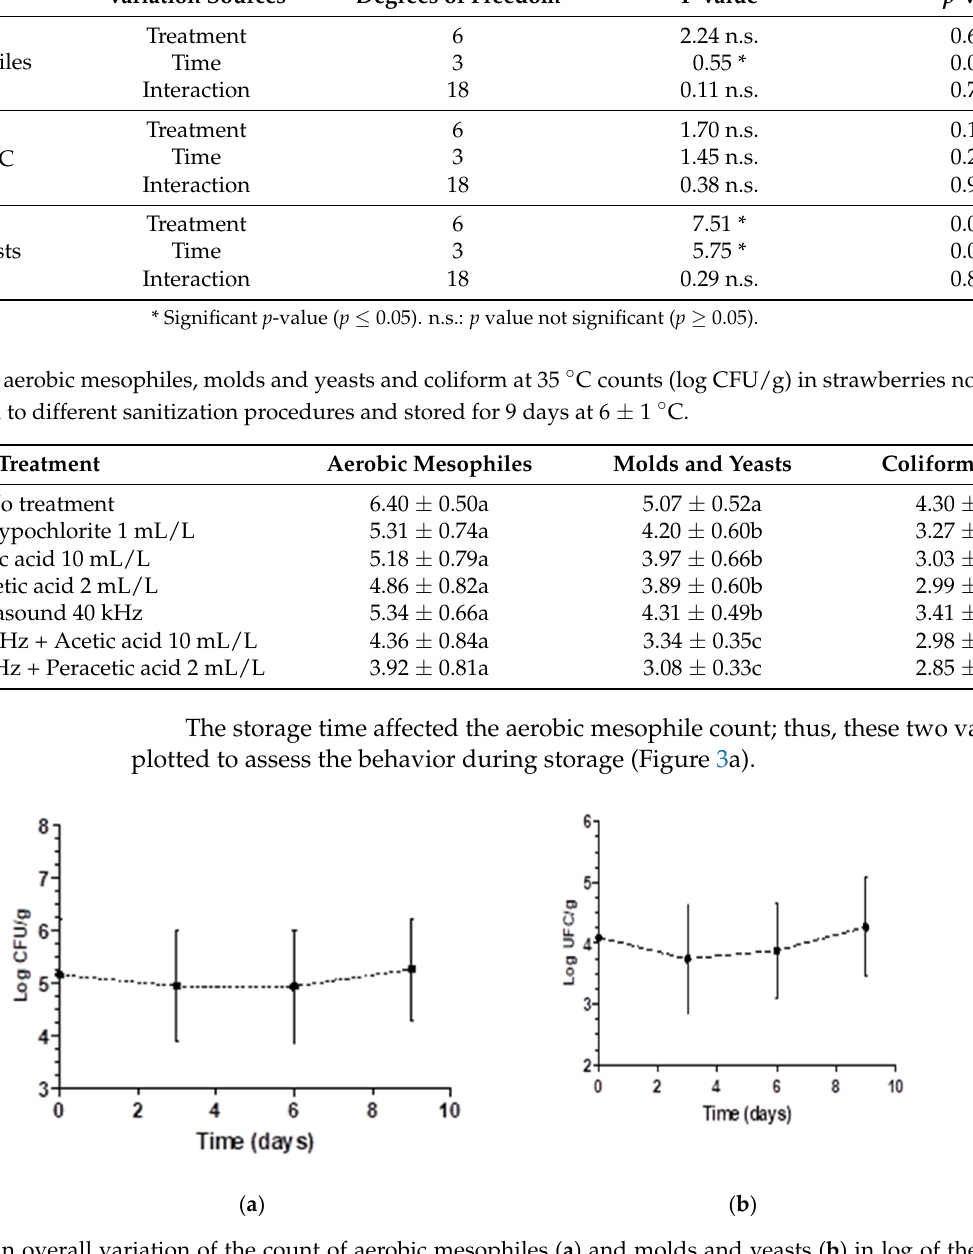
Figure 3. Mean overall variation of the count of aerobic mesophiles ( a ) and molds and yeasts ( b ) in log of the CFU/g evaluated in strawberries of each treatment during 9 days of storage.